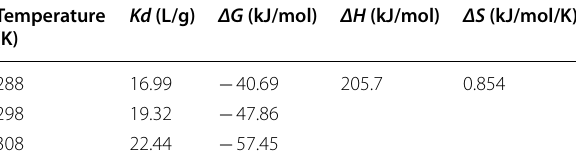
Table 4 Calculated thermodynamic